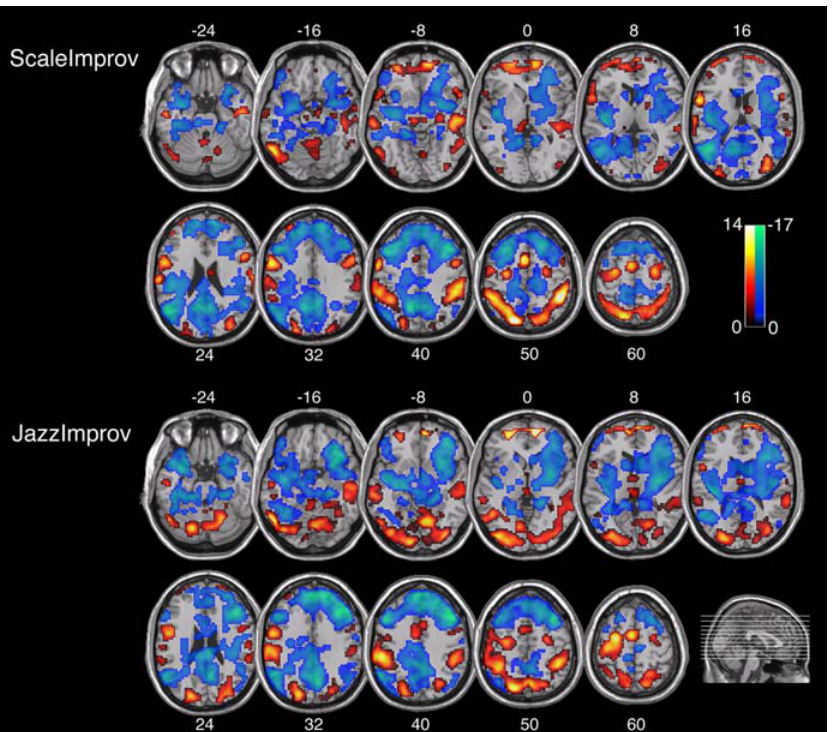
Figure 2. Axial slice renderings of mean activations (red/yellow scale bar) and deactivations (blue/green scale bar) associated with improvisation during Scale and Jazz paradigms. In both paradigms, spontaneous improvisation was associated with widespread deactivation in prefrontal cortex throughout DLPFC and LOFC, combined with focal activation in MPFC. In addition, increases in sensorimotor activity and decreases in limbic activity were seen in both paradigms. Activations were identified through inclusive masking of the contrast for [Improv–Control] with the contrast for [Improv–Rest], and deactivations were identified through inclusive masking of the contrast for [Control–Improv] with the contrast for [Rest–Improv] for both Scale and Jazz paradigms. The scale bar shows t-score values and the sagittal section shows an anatomical representation of slice location; both scale bar and sagittal slice insets apply equally to Scale and Jazz data. Labels refer to axial slice z-plane in Talairach